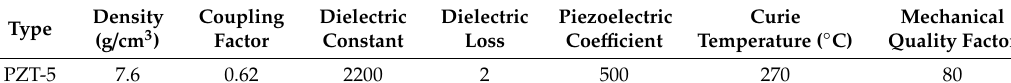
Figure 2. Settings of the grouting density: ( a ) cut rubber plugs; ( b ) sleeve locations where the grouting flowed out. Table 1. Material properties of type PZT-5.